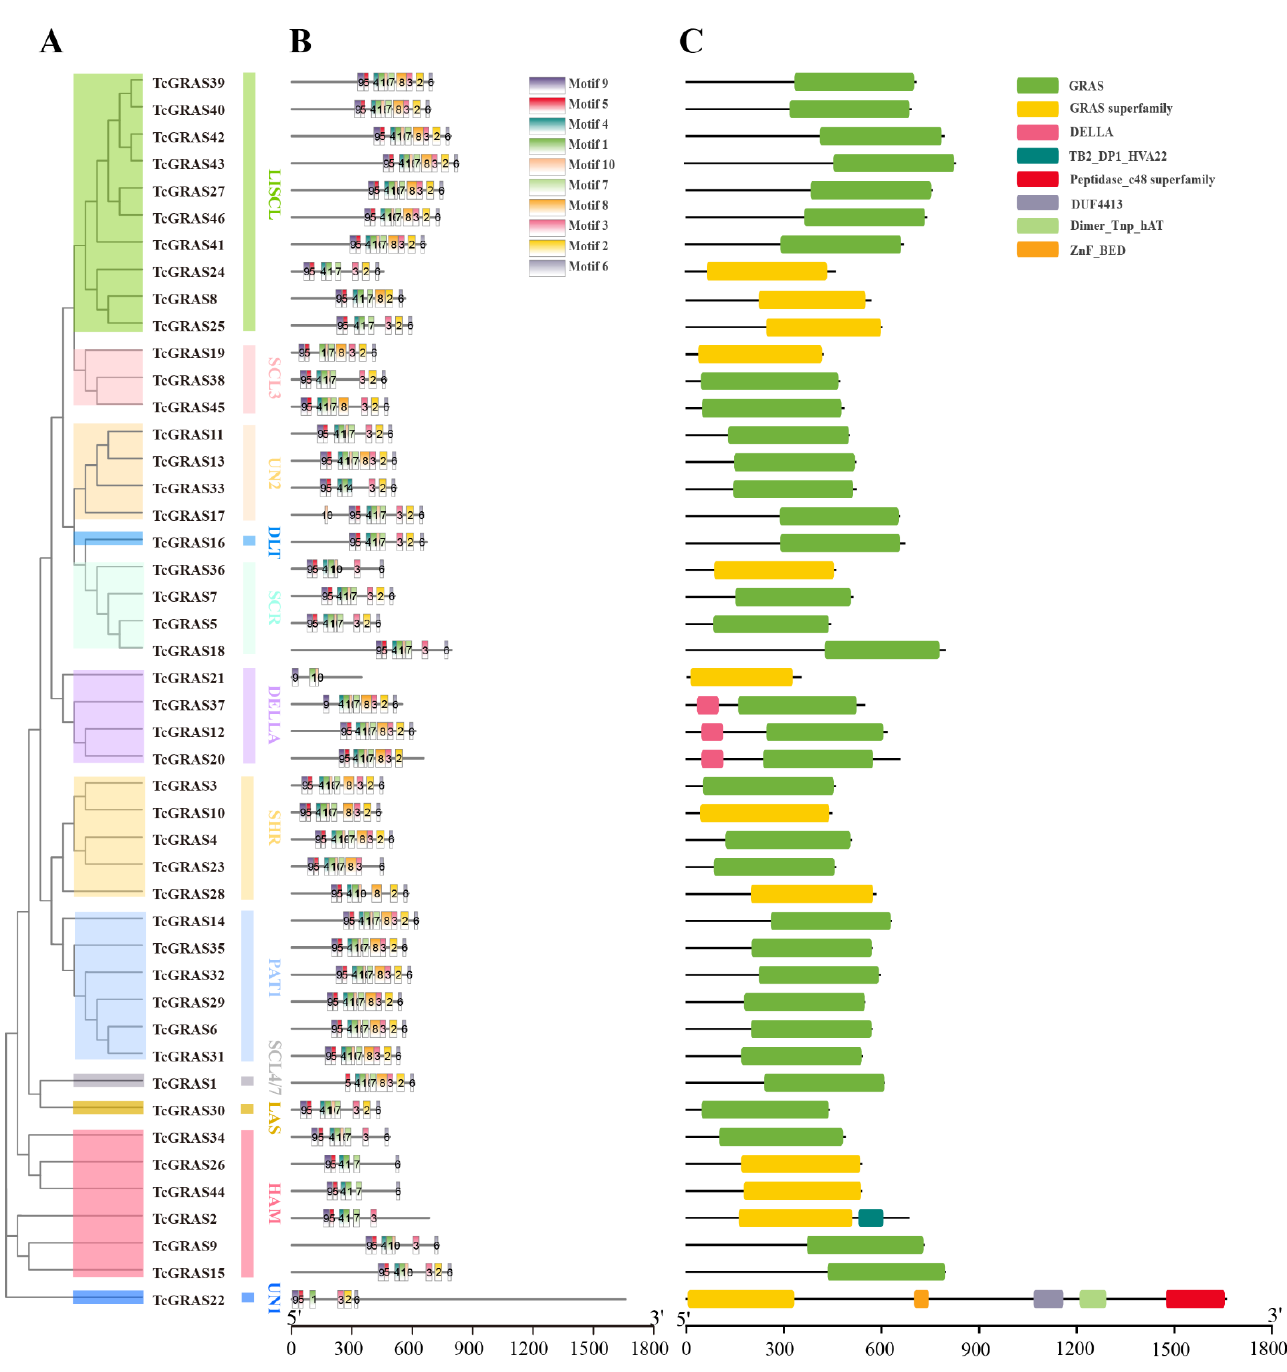
Figure 2. Phylogenetic relationship, conserved motifs, and gene structure of TcGRAS genes. ( A ) An unrooted phylogenetic tree of TcGRAS proteins was constructed using MEGA 11 software under the ML method with 1000 bootstrap replicates. ( B ) Conserved TcGRAS proteins’ motifs performed by MEME. The colored boxes refer to motifs. The black lines refer to non-conserved sequences. The scale bar is 300 amino acids. ( C ) The domain analyses of TcGRAS proteins were performed under the Gene Structure Display Server 2.0 program. The domains are displayed in different colored boxes.